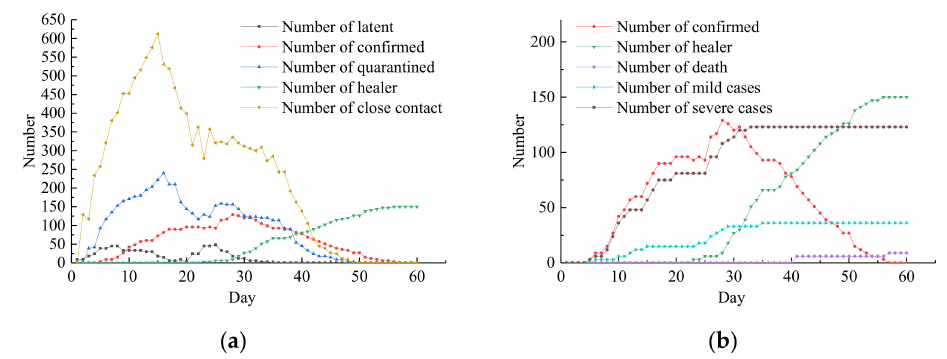
Figure 7. Medical life-saving intervention scenario: ( a ) number of resident agents in different states; ( b ) diagnosed and